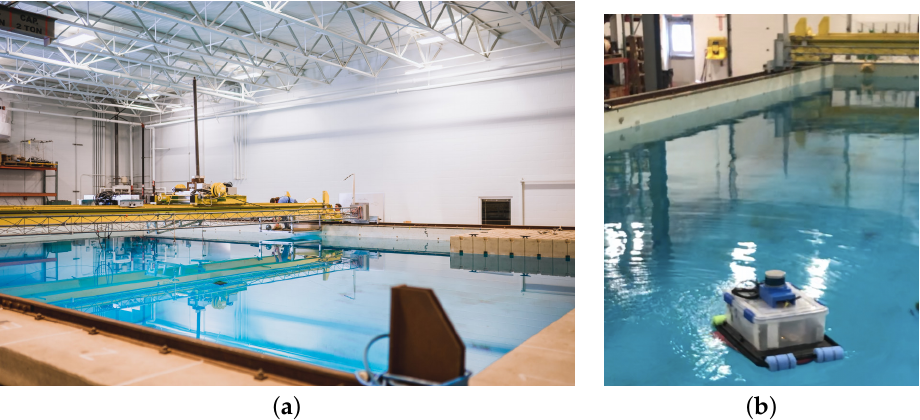
Figure 7. ( a ) The Chase Engineering Tank located at the University of New Hampshire ( b ) Small-Scale ASV Experimental Platform. Simulations are based upon the laboratory equipment shown